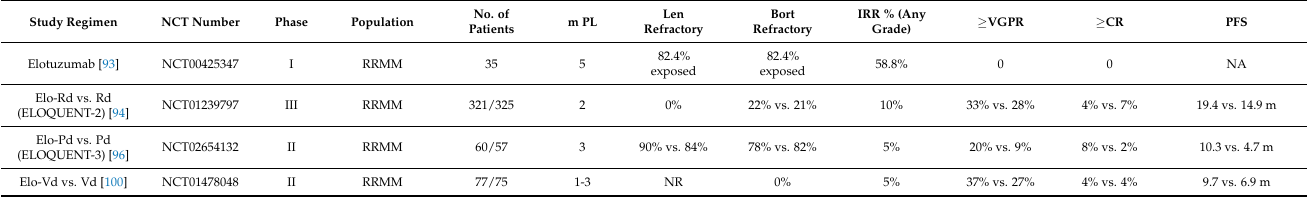
Table 7. Results of the important trials with regimens containing